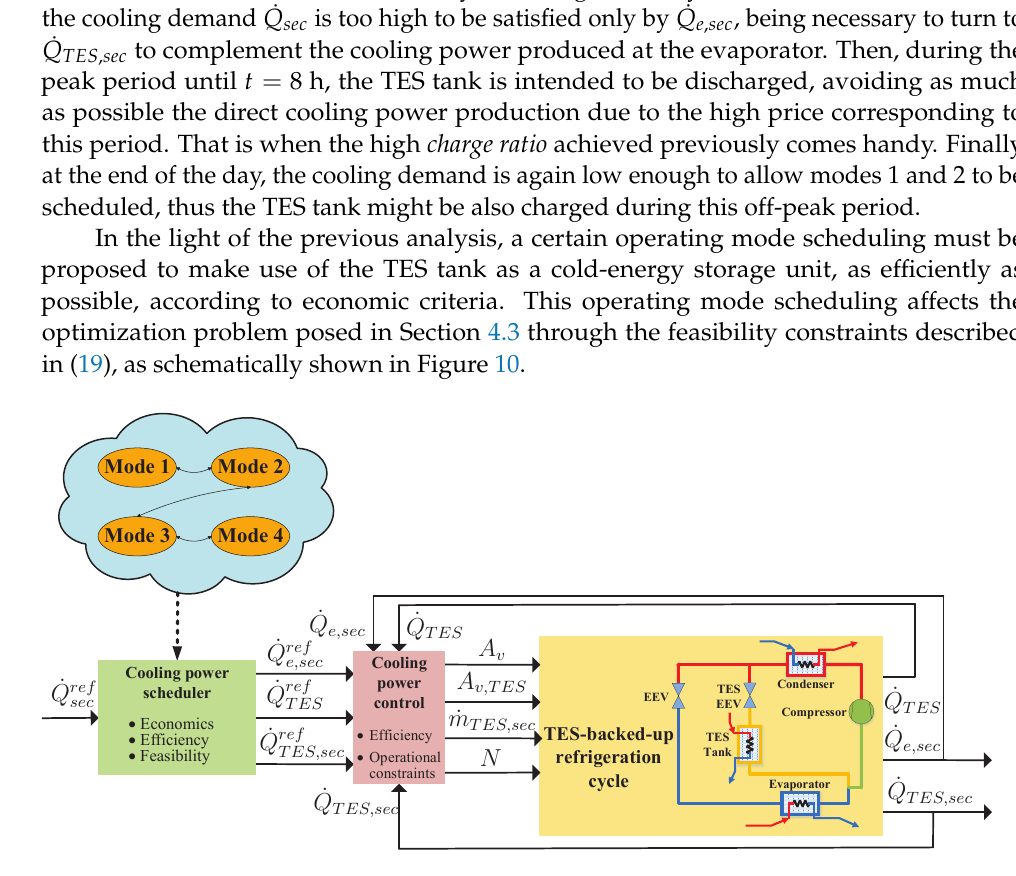
Figure 10. Influence of the operating mode scheduling on the NMPC optimization